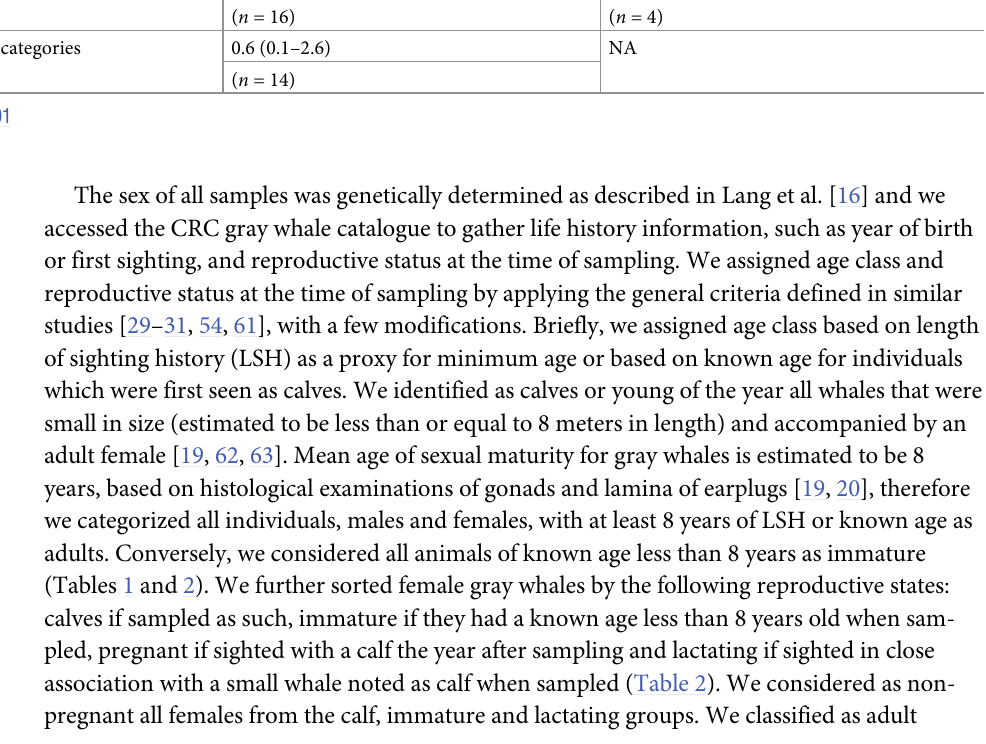
Table 2. Mean (range) of progesterone and testosterone concentrations (ng/g) in female gray whales divided by age class and reproductive